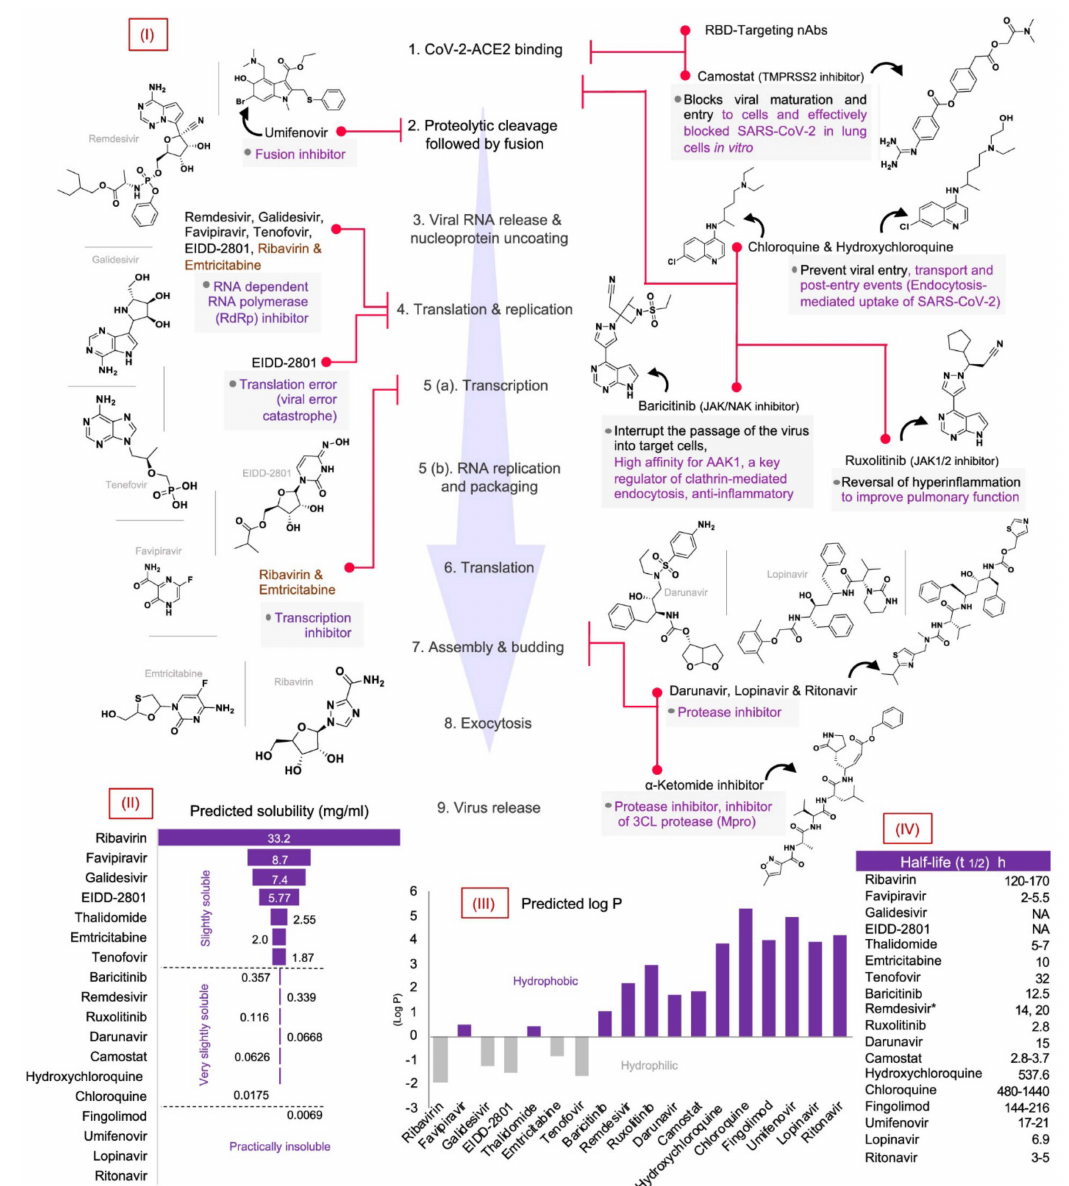
Figure 10. Antiviral molecules for COVID-19 therapeutics [112] (Reproduced with permission from [112]. Copyright Royal Society of Chemistry, 2020.); ( I ) mechanism, chemical structure and site of antiviral action, ( II , III ) solubility and log P, and ( IV ) half-life (t1/2) of antiviral